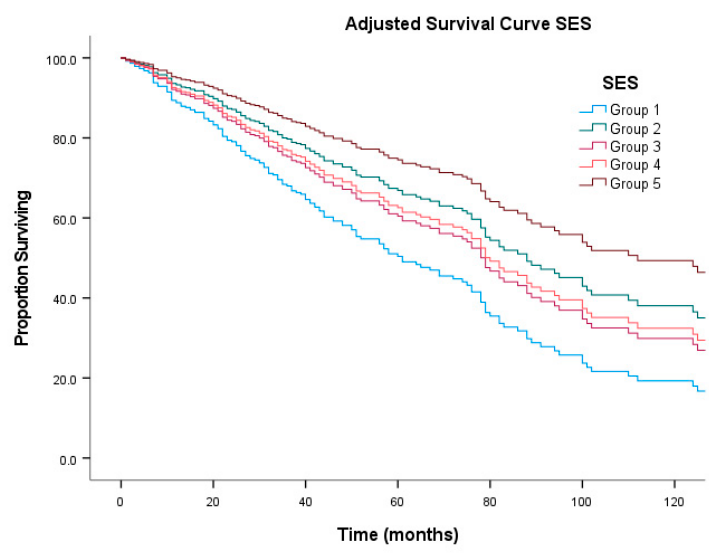
Figure 2. Adjusted survival curve stratified by socioeconomic status (SES).